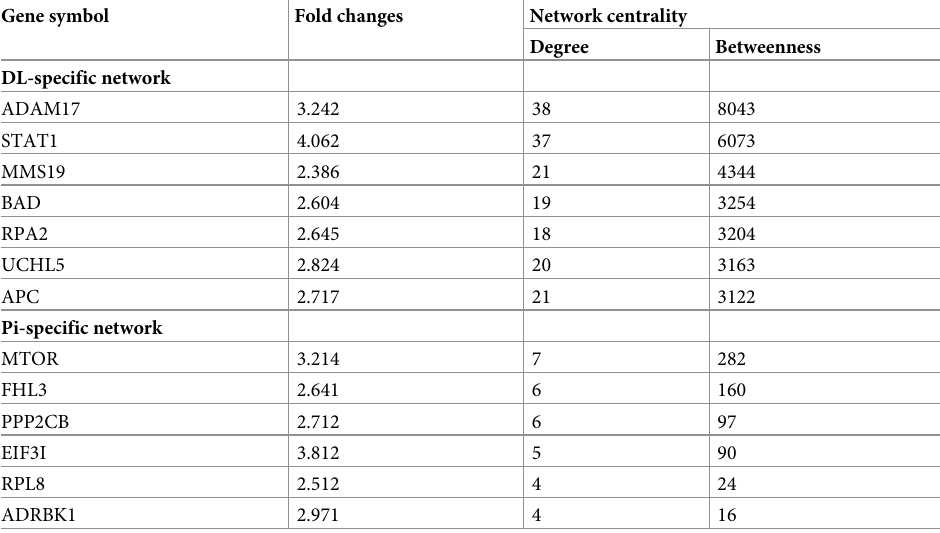
Table 2. Relative expression and network centrality estimates of hub genes of breed-specific transcriptome networks. Gene symbol Fold changes Network centrality